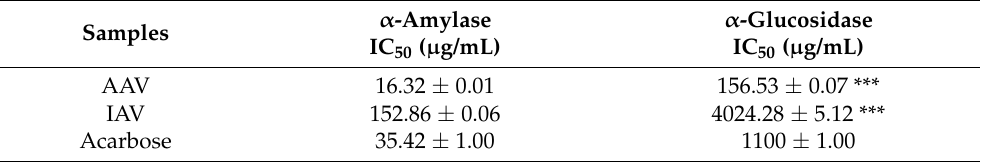
Data are expressed as mean ± SD. *** p <